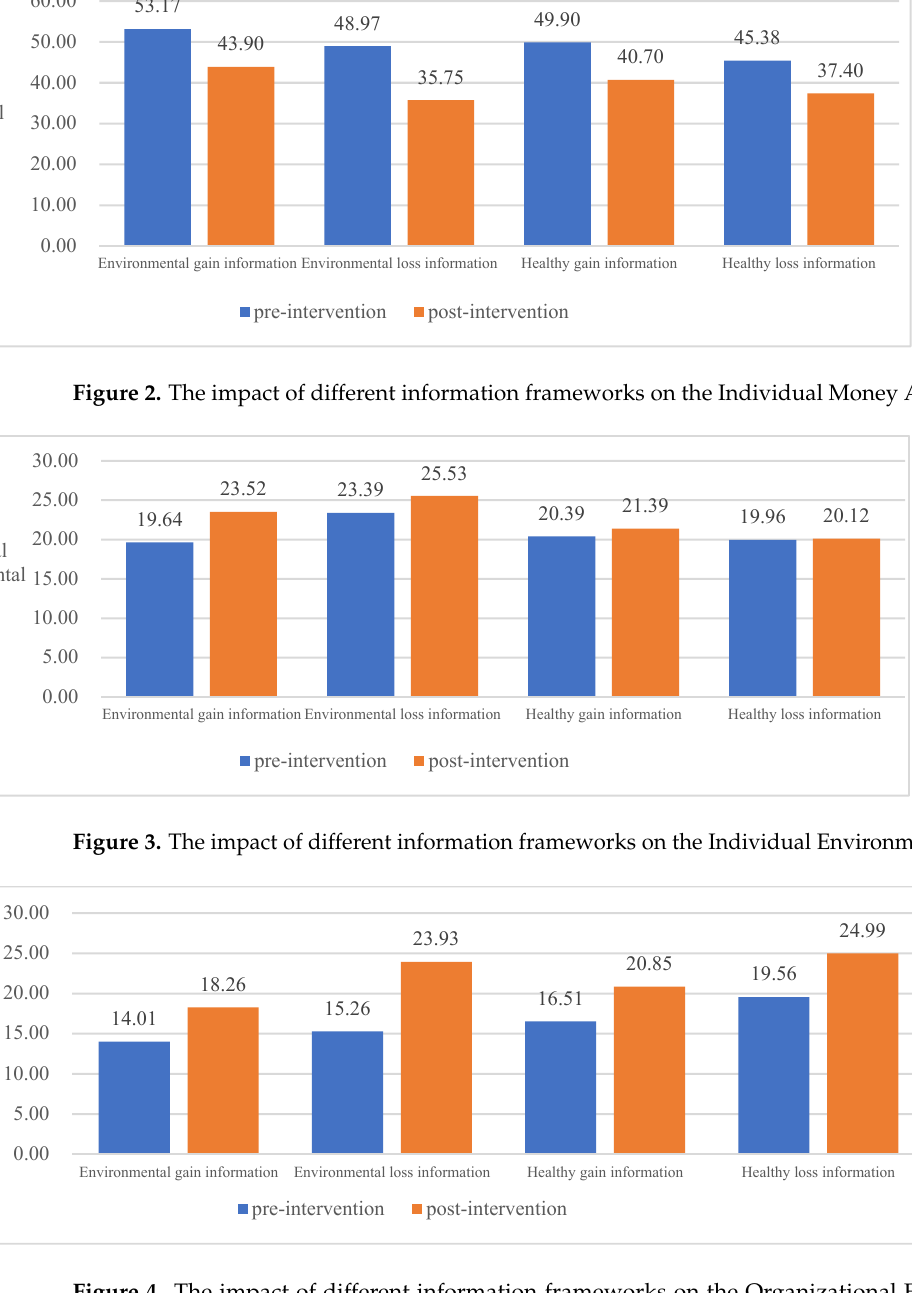
Figure 5 . The impact of different information frameworks on the Public Environmental Account.